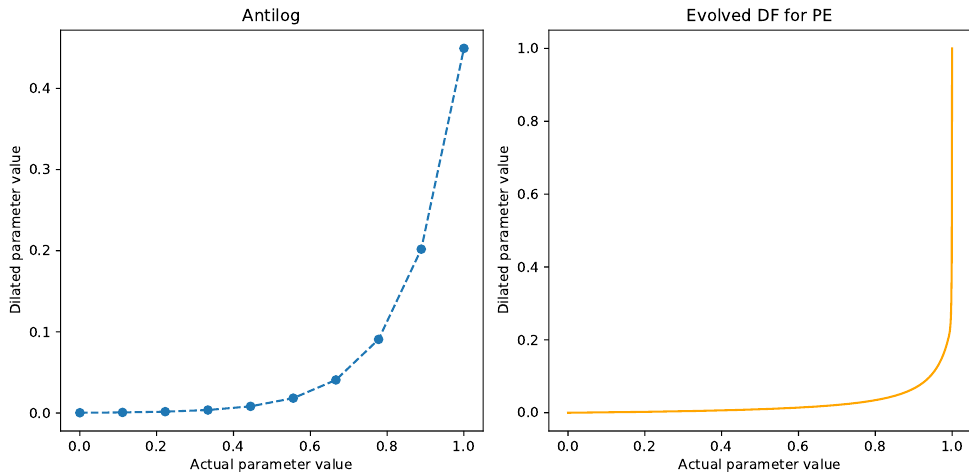
Figure 5. Graphical representation of the DF used in the PE problem. ( Left ): anti-log function analyti- cally designed to expand the fitness landscape in the lowest orders of magnitude. ( Right ): evolved DF that substantially performs the same dilation of the anti-log DF.